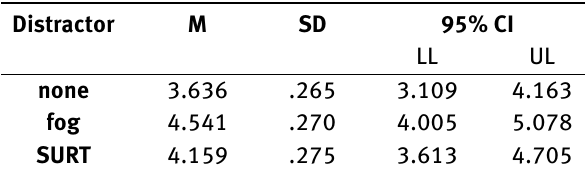
Table 2: Average drive variant-dependent response times, N =